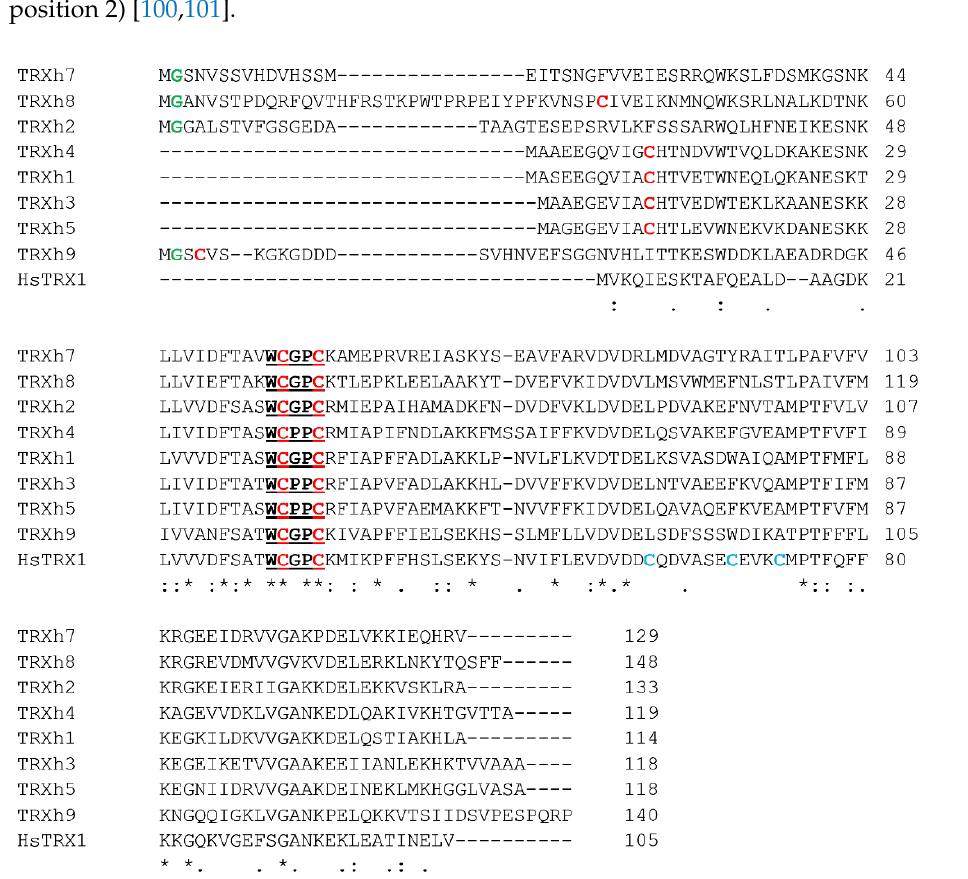
Figure 3. Conserved features of Arabidopsis h-type TRXs and human TRX1 protein sequences. Highlighted in red are the active site Cys residues as well as the N-terminal Cys. The catalytic motif is underlined and additional C-terminal Cys residues unique to HsTRX1 are in blue. Glycine residues that undergo N -myristoylation are in green. Asterisks (*) denote conserved residues, (:) strong and (.) weakly similar amino acid properties.